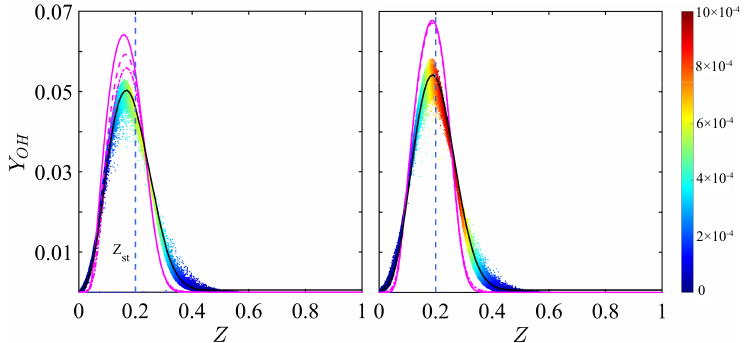
Figure 10. Scatter data colored according to the H mass fraction and the conditional means of the OH mass fraction in the mixture fraction space for (left) Case 1 and (right) Case 2. The solid black line represents the LES’s conditional statistical results. The purple curves correspond to laminar counter- flow flames with different stoichiometric scalar dissipation rates: (solid) 2 s − 1 , (dashed) 500 s − 1 , and (dash-dotted) 6000 s − 1 . The vertical dashed lines mark the stoichiometric mixture